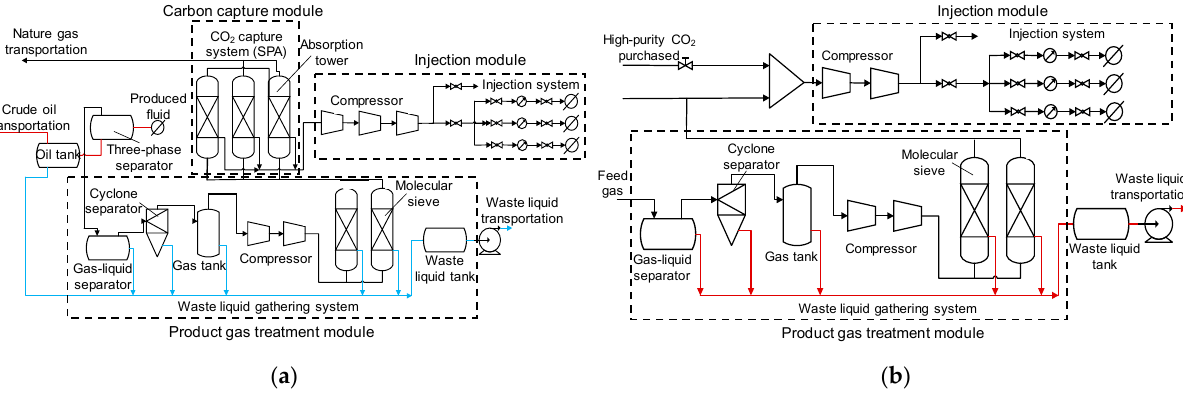
Figure 2. The CCRPs designed in CO 2 EOR and storage project in XinJiang Oilfield. ( a ) Typical CO 2 PSA capture and reinjection process; ( b ) Direct reinjection process with purchased CO 2 .